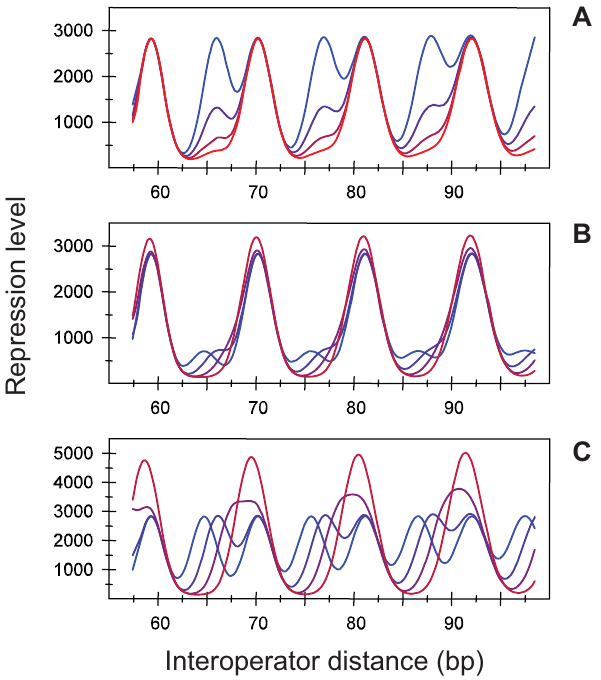
Figure 4. Effects in gene expression of the free energy of looping for a two-conformation elastic DNA model. Repression levels obtained with Equation 3 using the corresponding free energies of Figure 3. (A) Differences in optimal free energies are varied and the optimal phases are kept fixed. (B, C) Differences in optimal phases are varied and optimal free energies are kept fixed at two different values: 1 kcal/mol (B) and 0 kcal/mol (C).